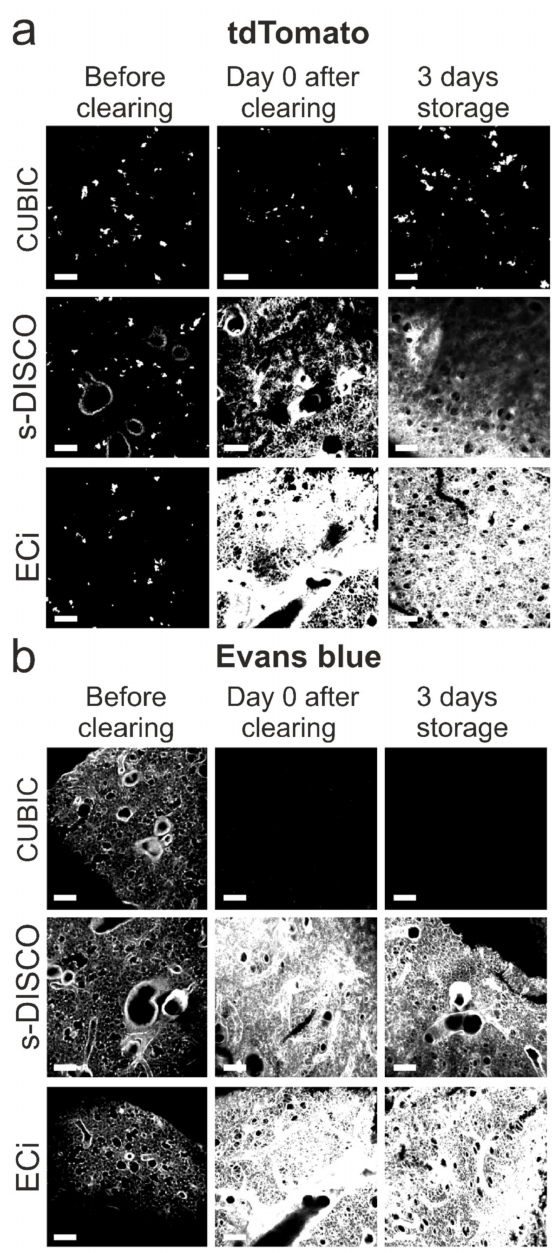
Figure 3. Fluorescence preservation of tdTomato and Evans Blue after clearing thick lung sections. Impact of CUBIC, s-DISCO and ECi clearing on the fluorescence of ( a ) tdTomato or ( b ) Evans Blue in 500 µ m thick lung sections before, immediately after, and after storage for 3 days in RI solution. All confocal images are maximum-intensity projections (MIPs), taken from the surface of the slices. The same exposure times and display settings were used to acquire and visualise the images to reflect the change in the fluorescence preservation accurately. Scale bars = 150 µ